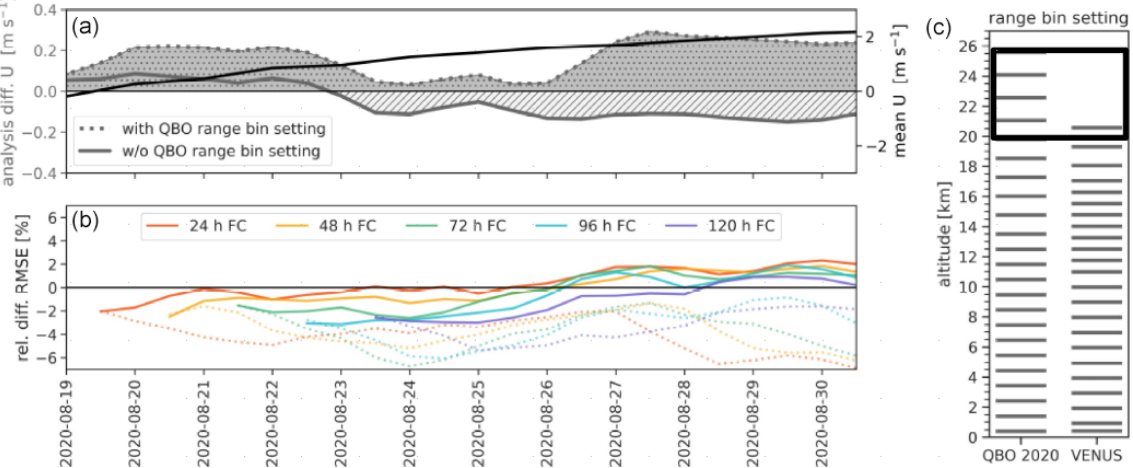
Figure 3. Time series for the tropical belt ± 10 ◦ latitude between 30 and 50hPa. (a) The mean zonal wind (black line) and the mean analysis differences in the zonal wind between EXP_A and CTRL (shaded grey), with (dotted line) and without (solid line) the QBO range bin setting. (b) Relative differences in RMSE between EXP_A and CTRL for forecast lead times from 24 to 120h, with (dotted line) and without (solid line) the QBO range bin setting. The distribution of the general tropical range bins (VENUS) and the advanced QBO setting is illustrated in panel (c) , with the black rectangle highlighting the 30–50hPa